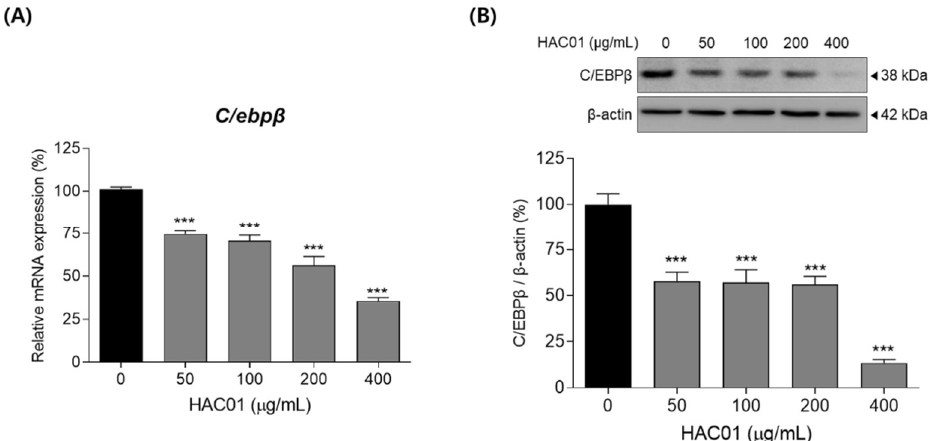
Figure 4. Effects of Lactobacillus plantarum HAC01 lysate on the expression of C/EBP β in 3T3-L1 cells. Adipocyte differentiation was induced in the presence of L. plantarum HAC01 lysate for 4 h. ( A ) mRNA expression of C/ebp β quantified using qRT-PCR. ( B ) Protein expression levels of C/EBP β compared to β -actin quantified using Western blotting. Representative bands from triplicate experiments are shown. C/EBP β , CCAAT/enhancer-binding protein beta. All results are presented as mean ± SD. *** p < 0.001 vs. 0 μg/mL.